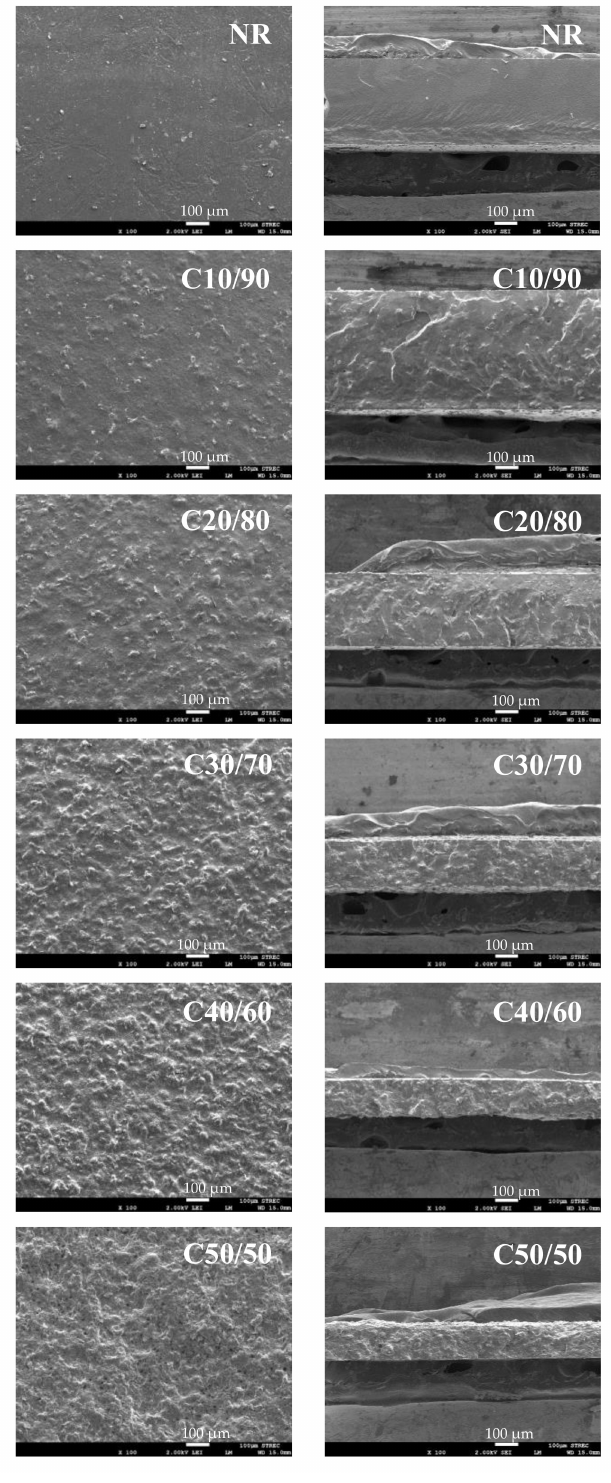
Figure 2. SEM images of surface (left) and cross-section (right) of NR and MFC–NR composite